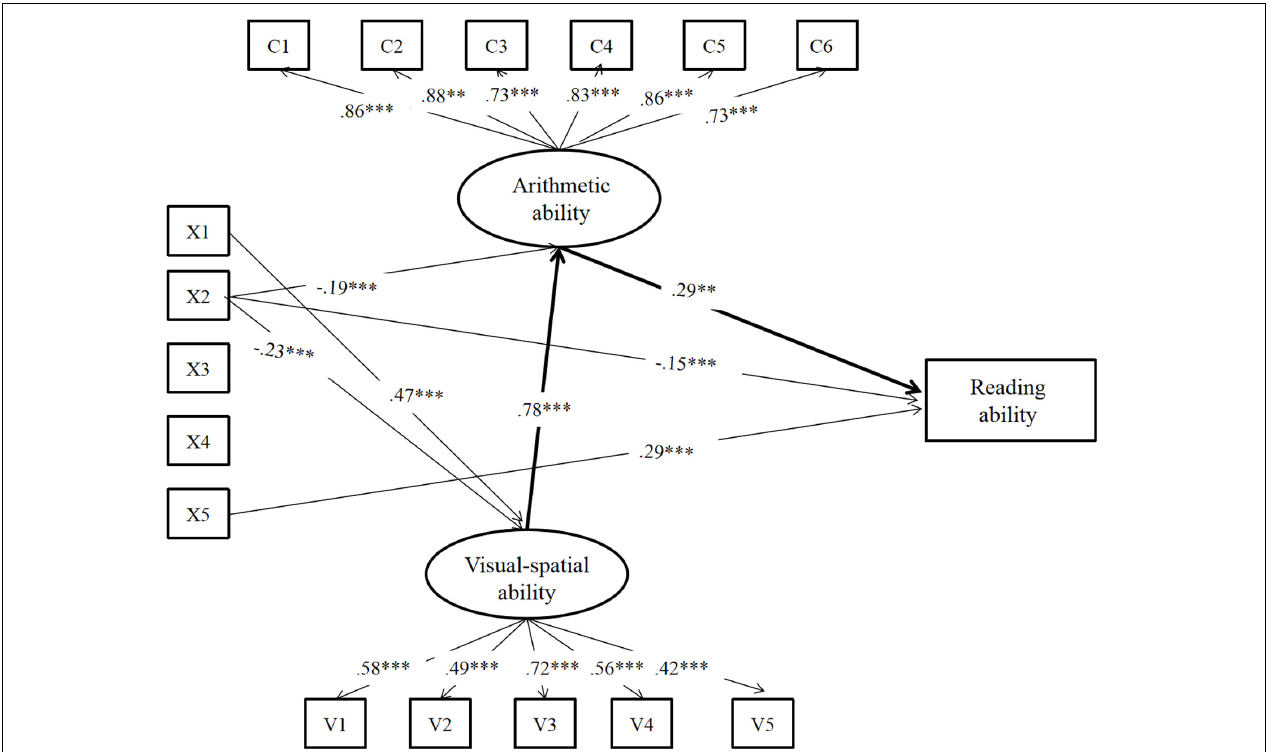
FIGURE 1 | Mediation effect of arithmetic ability between visual–spatial ability and reading ability. V1–V5: number continuation; visual length; figure counting; square counting; number connection. C1–C6: addition; subtraction; multiplication; division; comparison; blank filling. X1: IQ; X2: RAN; X3: onset and rime deletion; X4: phoneme deletion; X5: morphological production. One-headed arrows represent significant paths; non-significant paths are not represented. ∗∗ p < 0.01, ∗∗∗ p < 0.001.